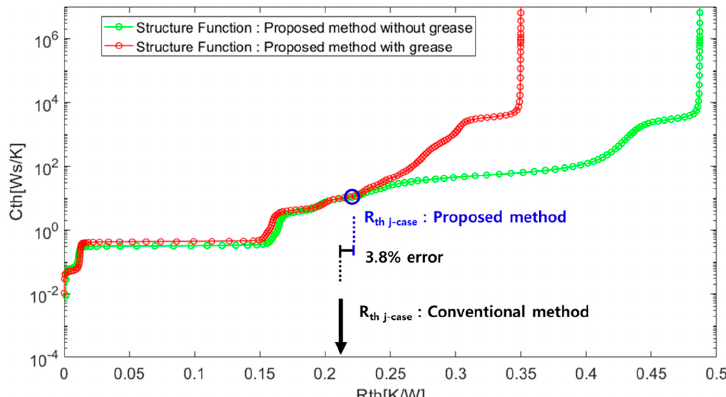
Figure 9. Extracted thermal structure function showing the thermal resistance and capacitance (with and without thermal grease). The thermal resistance measured by the conventional method is marked by the black